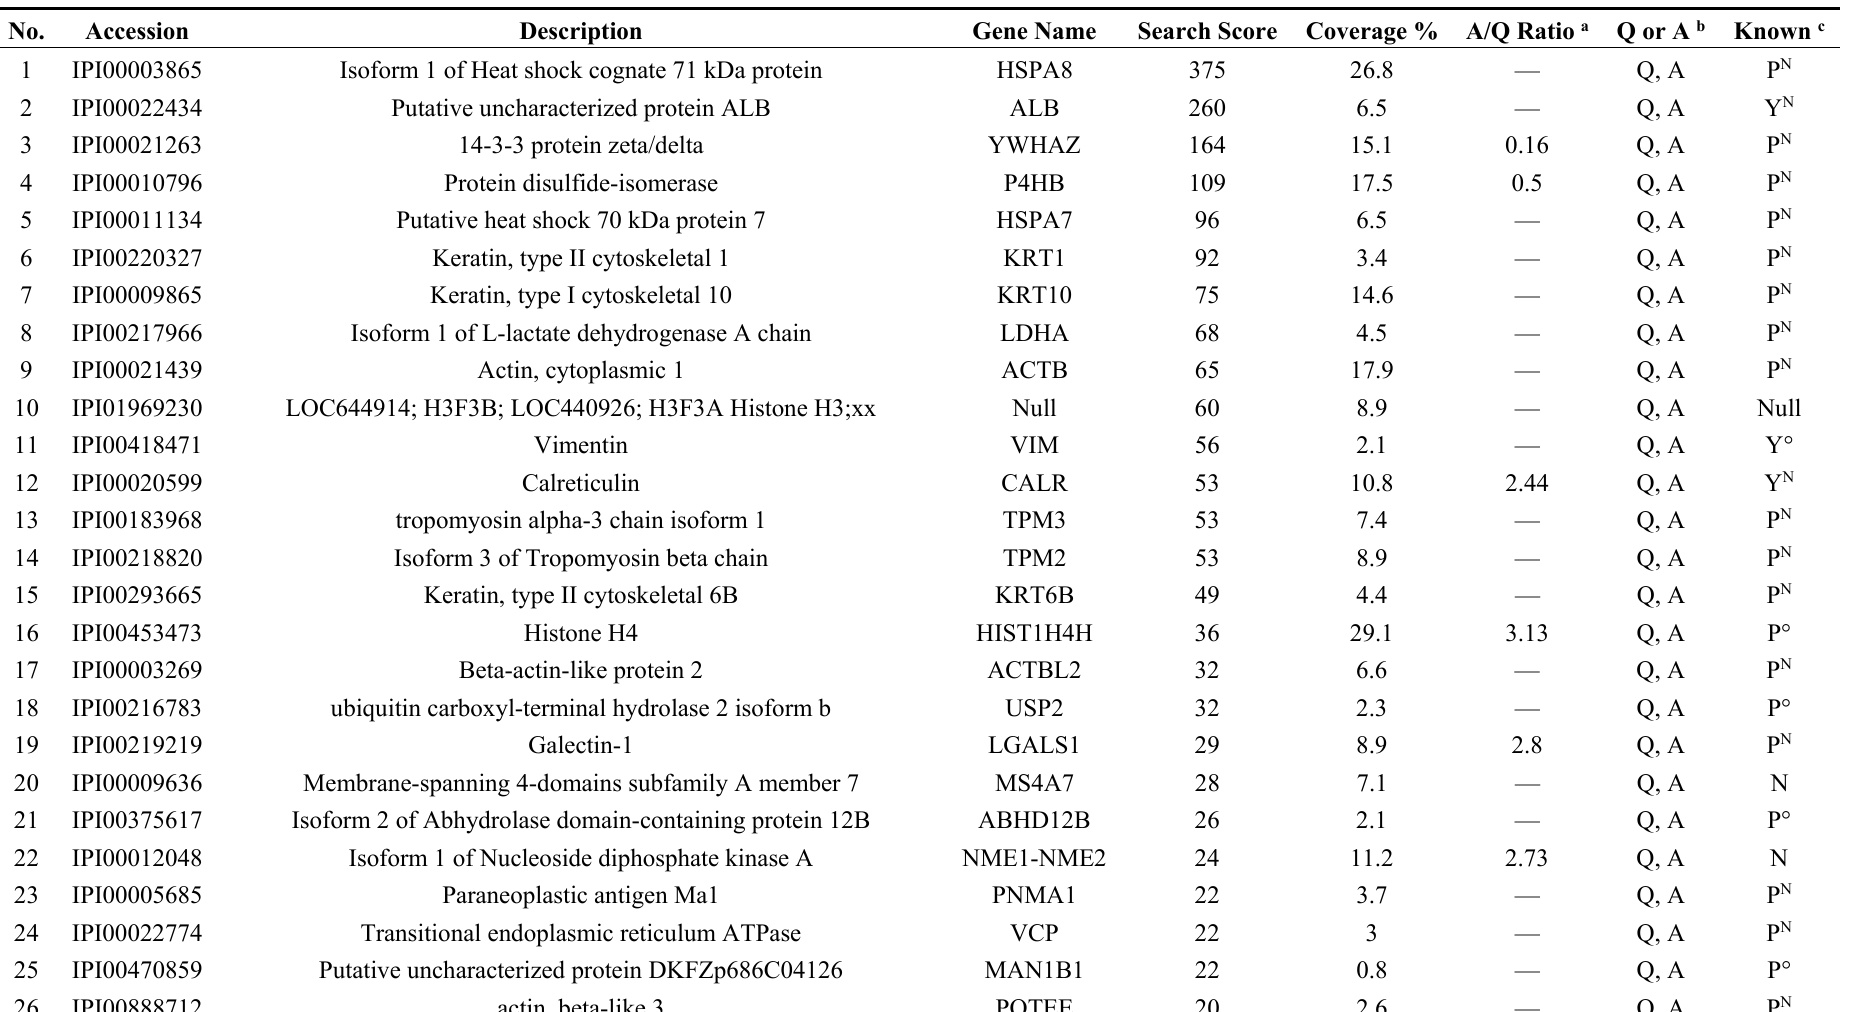
Table 1. Detailed information about the CBGs (ConA-binding glycoproteins) isolated by CMPCs (ConA-magnetic particle conjugates) from activated and quiescent LX-2